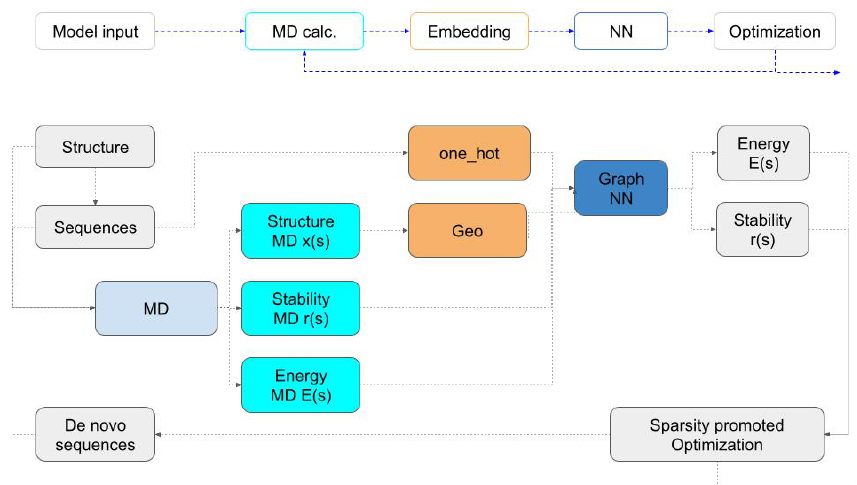
Figure 1. Design workflow. Input model structure and sequences are processed by MD simulations to generate time trajectories of structure, stability, and energy. All metrics are used to establish PINNs, followed by a sparsity-promoted optimization algorithm. The output is either used to retrain the model or outputs the suggested optimized